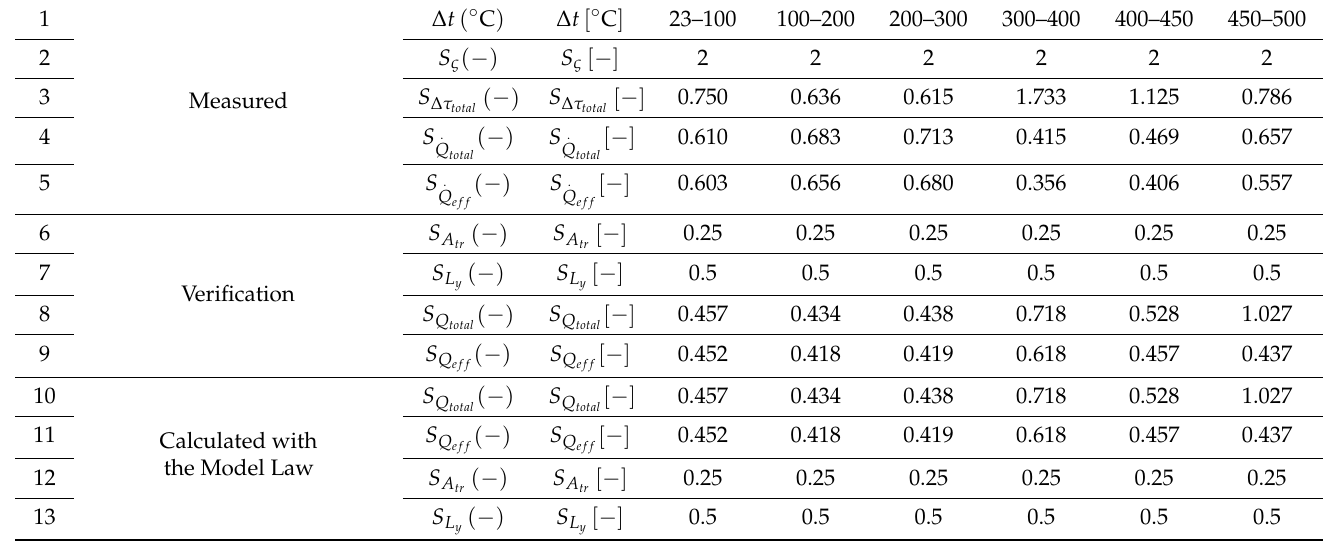
Table 8. The 1:2/1:1 painted model/prototype; measured